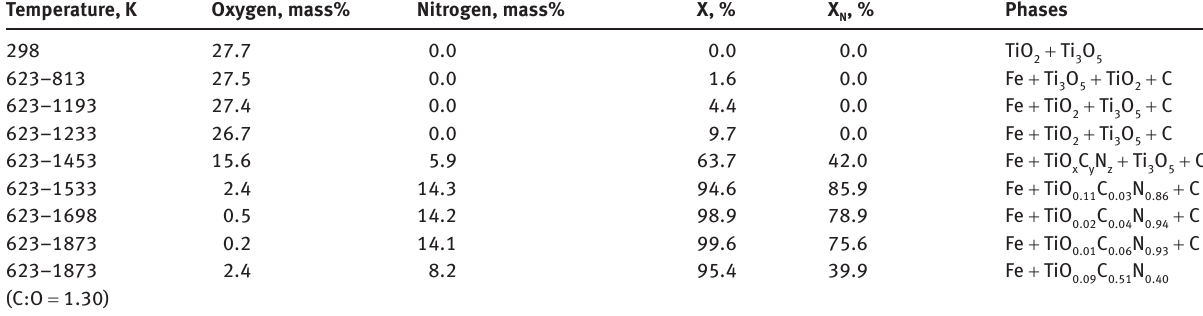
-N gas mixture to the 2 2